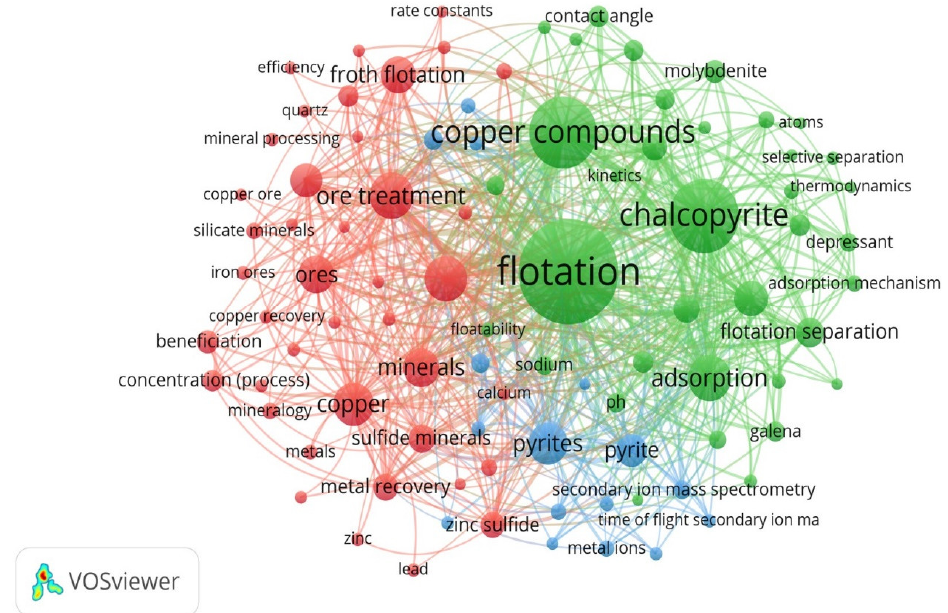
Figure 3. Text pattern analysis during the last decade (2010–2020) literature survey to visualize its scientific trends (more occurrences in larger circles).